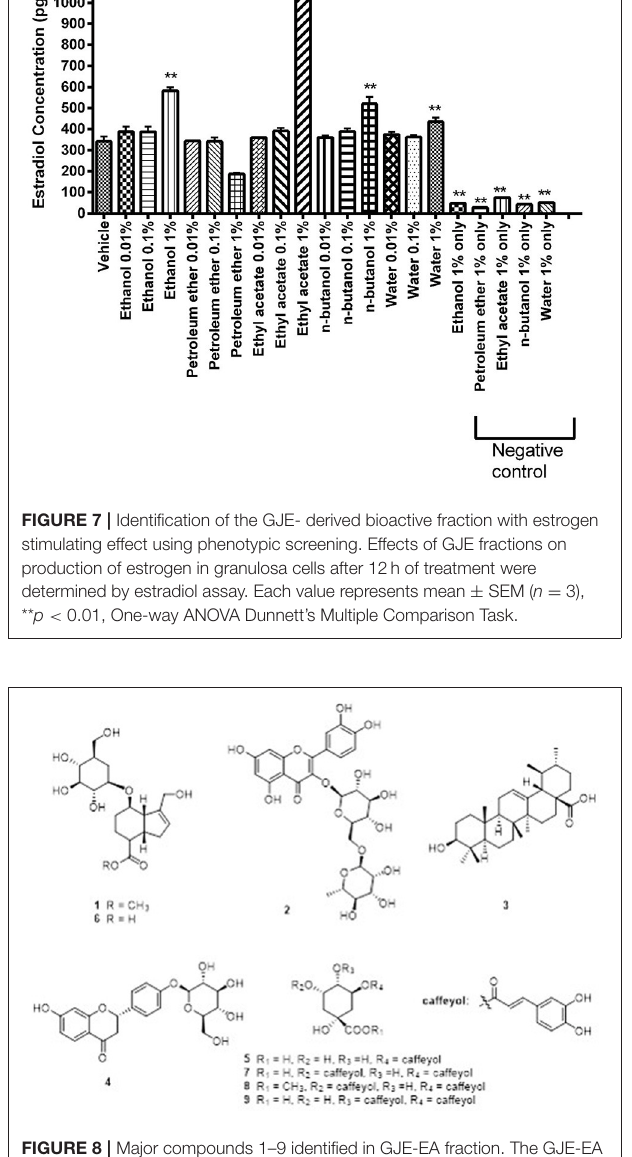
be able to increase StAR levels in ovarian granulosa cells ( Figure 11D ).